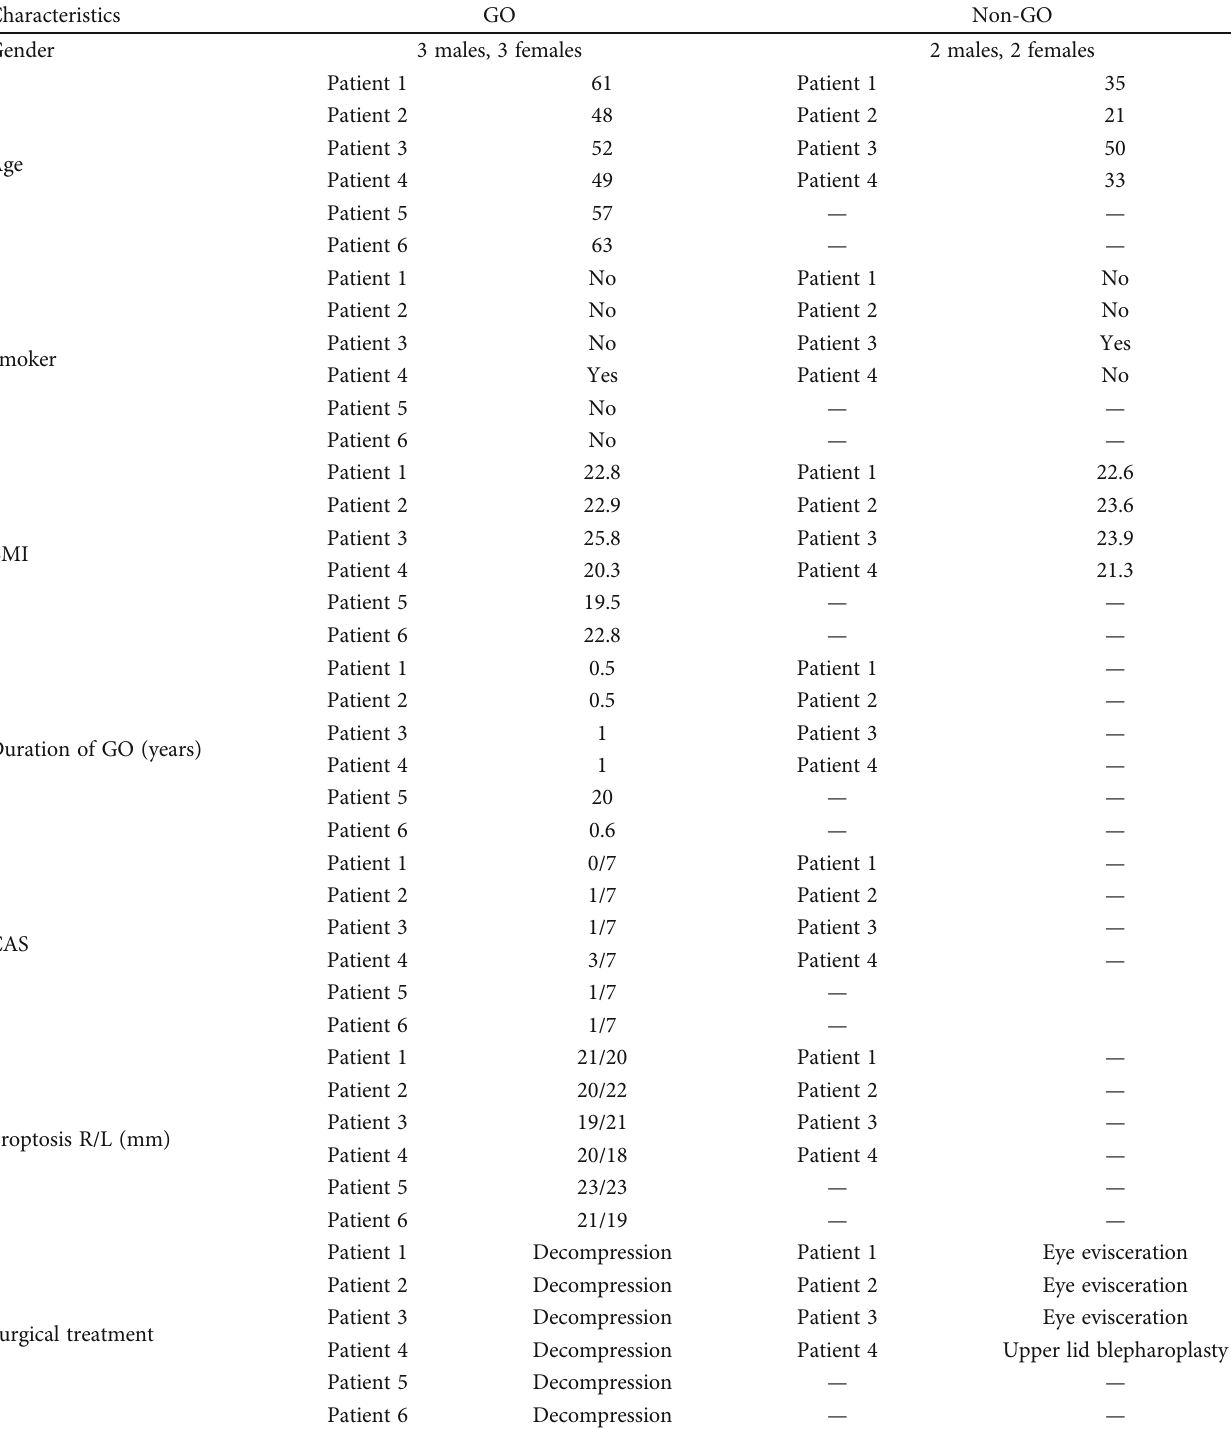
Table 1: Disease information and clinical characteristics of patients taking orbital tissue samples.